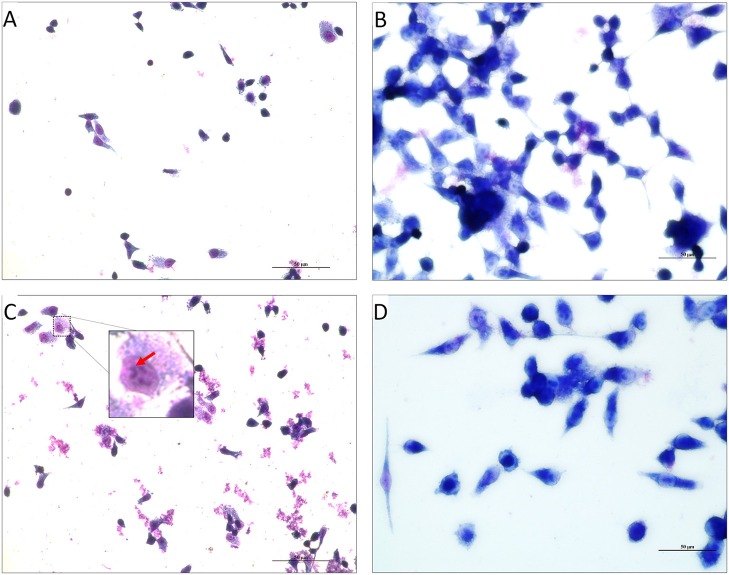
Light Micrographs showing the invaded V. cholerae onto INT 407 monolayer cells. (A,C) INT 407 cell lines invaded by the PDCApy untreated MTCC3905 and Vc4, respectively. The coma shaped V. cholerae cells that are invaded in the INT 407 cell lines can be distinctly seen in the untreated control (inset, enlarged image).The invasion of the V. cholerae cells into intestinal epithelial cells were unhealthy (rounded and detached). (B,D) PDCApy treated V. cholerae showed reduced invasive property, leading to healthy intestinal cells. Scale bar in micrographs represents 50 μm.